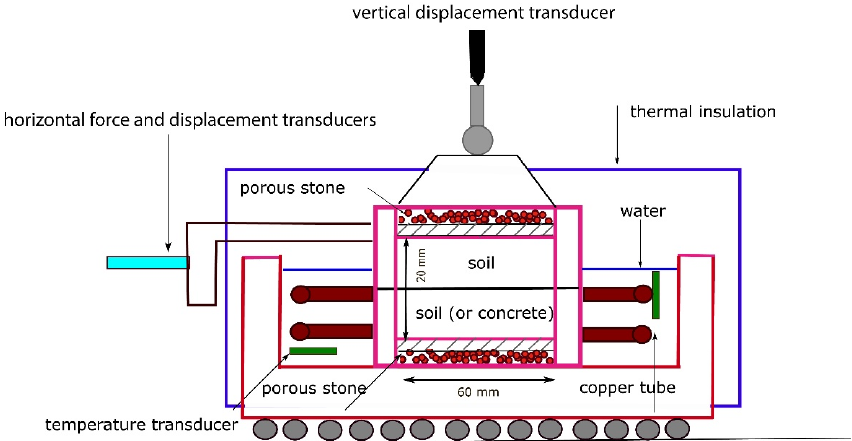
Figure 27. Direct shear apparatus with temperature control system (adapted from Reference [184]).